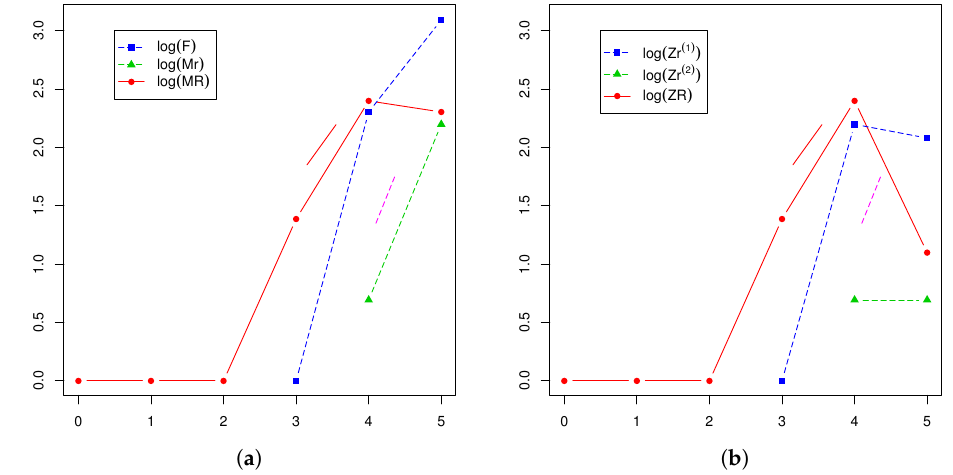
Figure 7. Evolution generation-by-generation of { ( log ( F n ) ,log ( Mr n ) ,log ( MR n )) } 0 ≤ n ≤ 5 ( a ) and { ( log ( Zr ( 1 ) ) ,log ( Zr ( 2 ) ) ,log ( ZR n )) } n n 0 ≤ n ≤ 5 ( b ), together with log (dotted straight